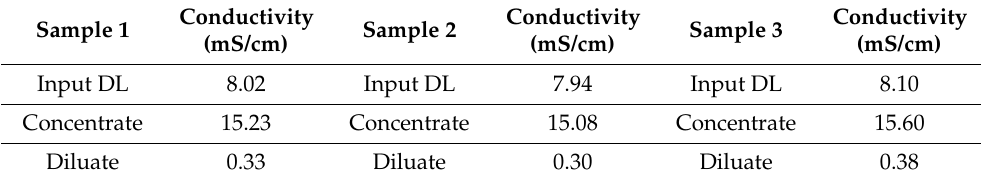
Table 3. Conductivity of input DL and ED products.